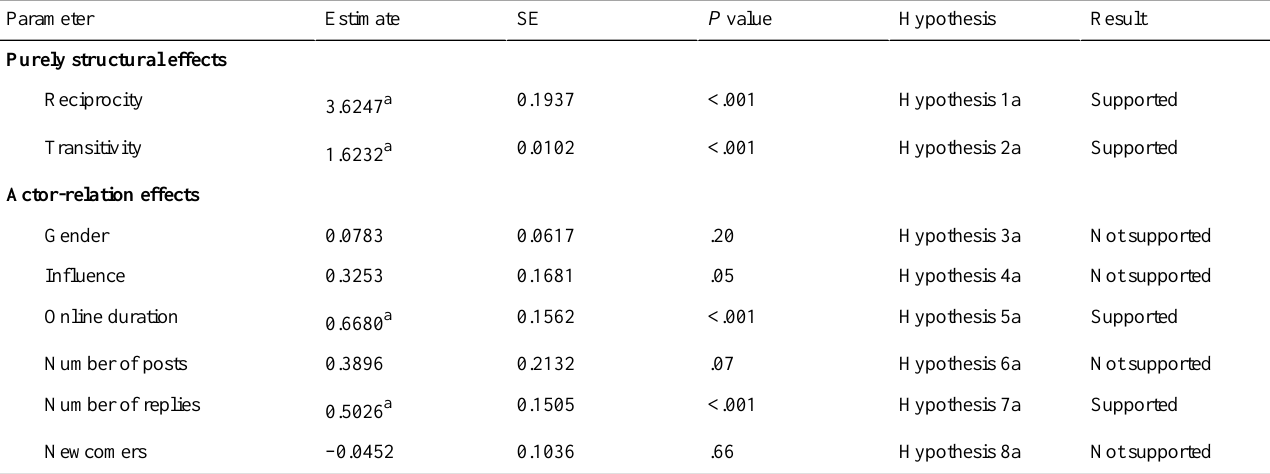
Table 1. Exponential random graph model estimates for the informational support network.